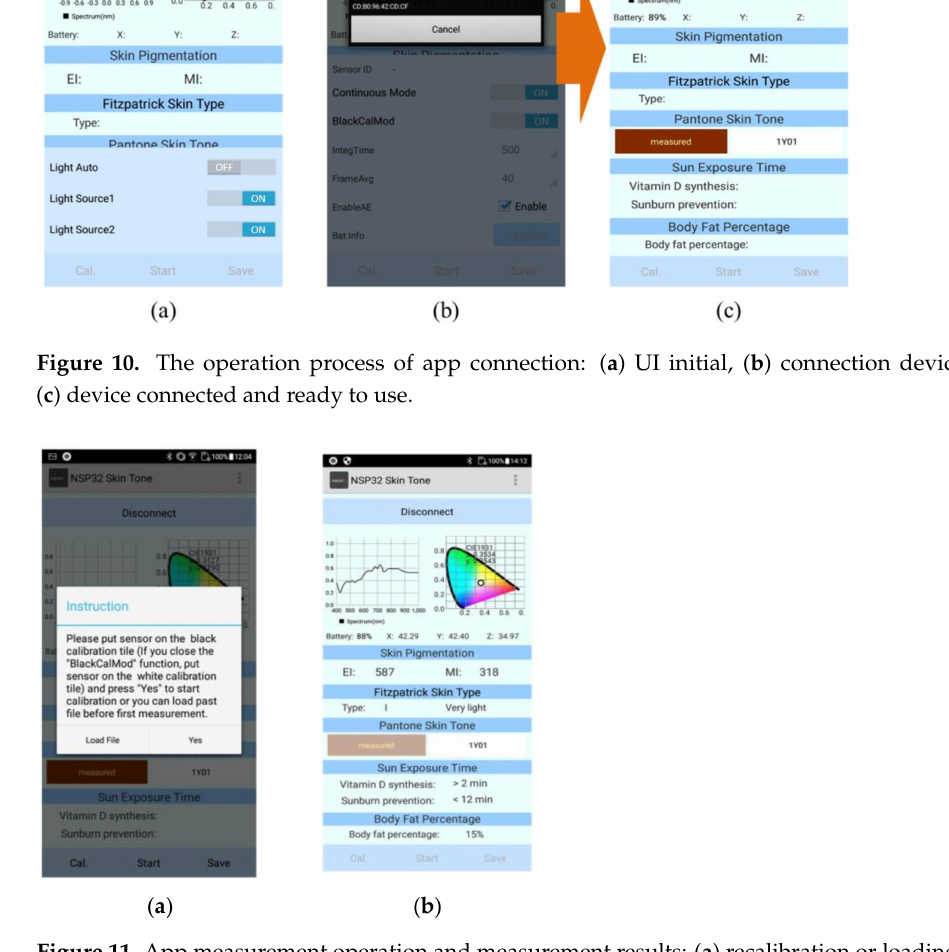
Figure 11. App measurement operation and measurement results: ( a ) recalibration or loading of the calibration file; ( b ) skin spectral analysis and related application